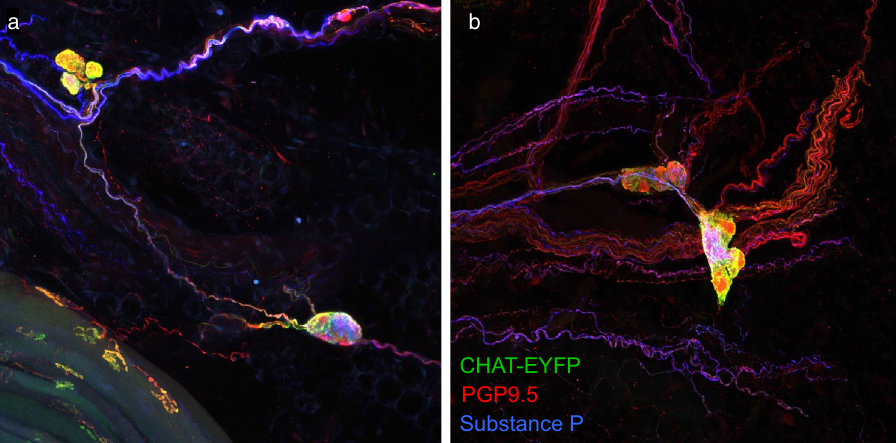
Figure 8. Examples of substance P (blue) nerves in parasympathetic ganglia in mice with CHAT driving expression of EYFP (green) co-stained with PGP9.5 (red). ( a ) A parasympathetic ganglion with three cell bodies and a single substance P neuron both expressing EYFP. ( b ) A densely innervated parasympathetic ganglion with one of its neurons expressing substance P and all expressing